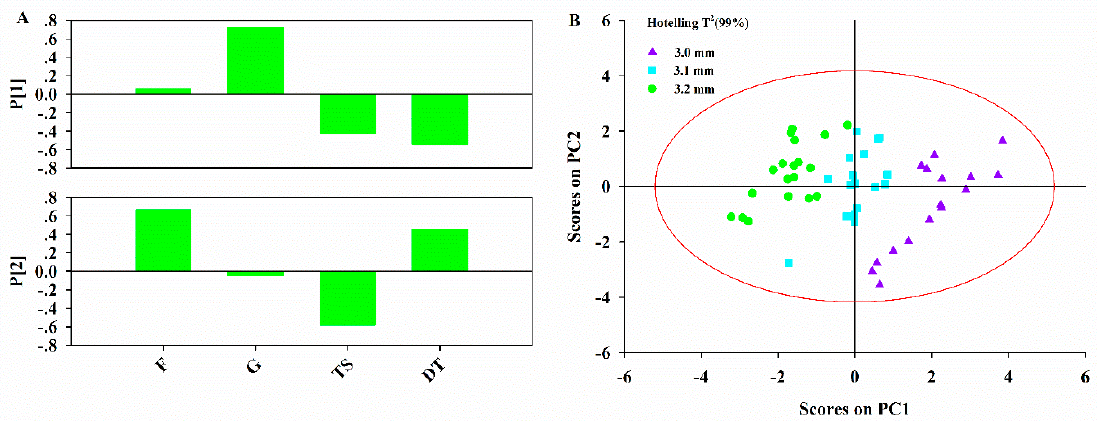
Figure 7. ( A ) Loading bar plots of PCA model on data block [ X 3 , Y ]; ( B ) Score plot of PCA model on data block [ X 3 , Y ]. F and G refer to lubrication time and minimal punch tip separation distance, respectively.